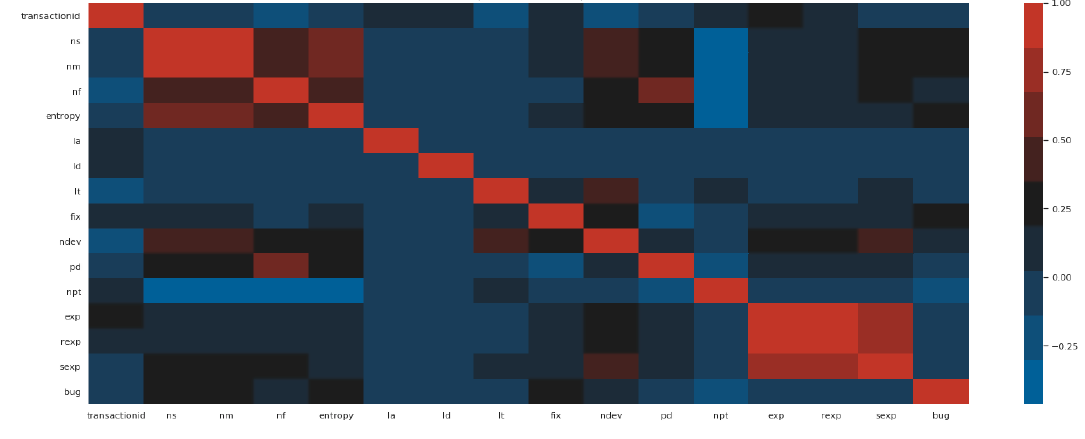
Figure 4. Subsample correlation matrix of attributes.